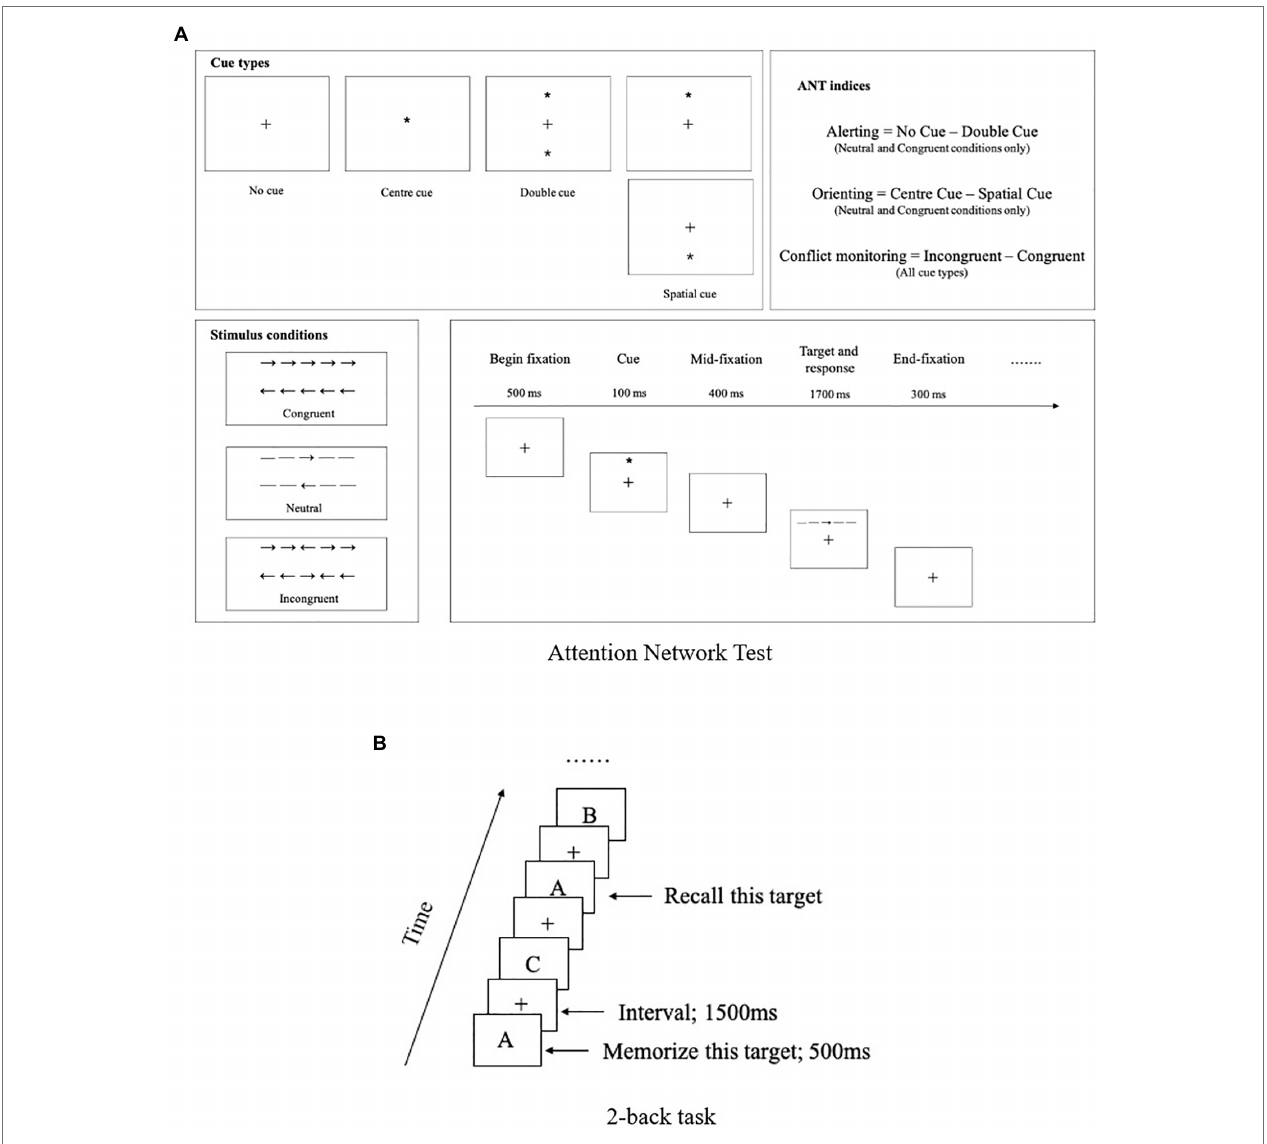
FIGURE 1 | Experiment design for attention network test (A) and 2-back task (B)